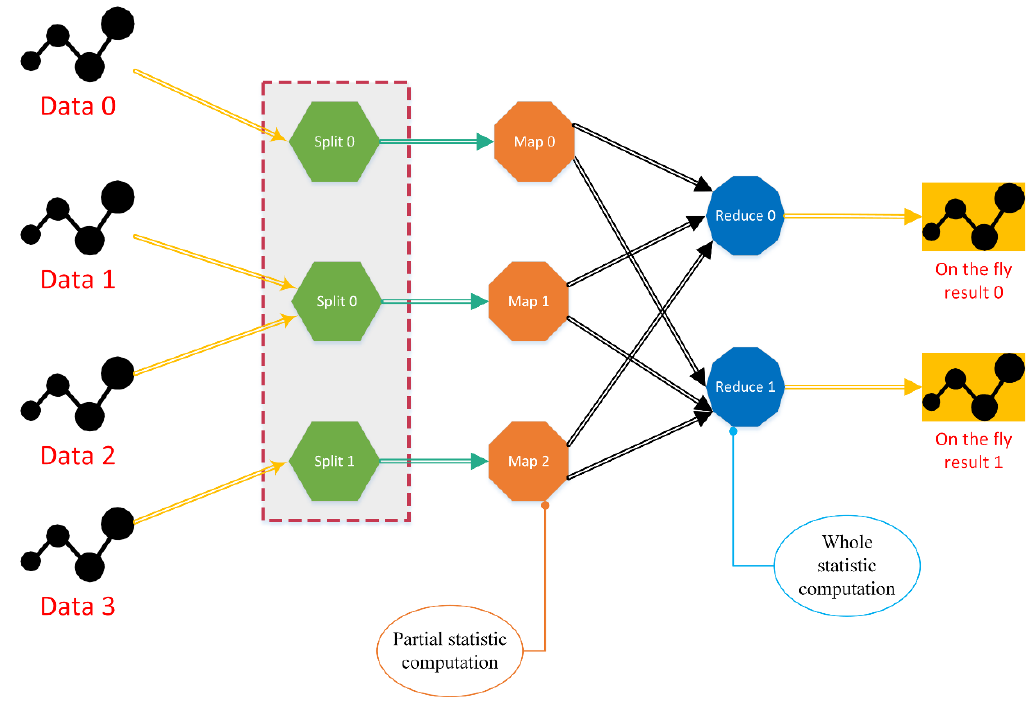
Figure 3. Map/reduce workflow of in situ sensors in the proposed framework.